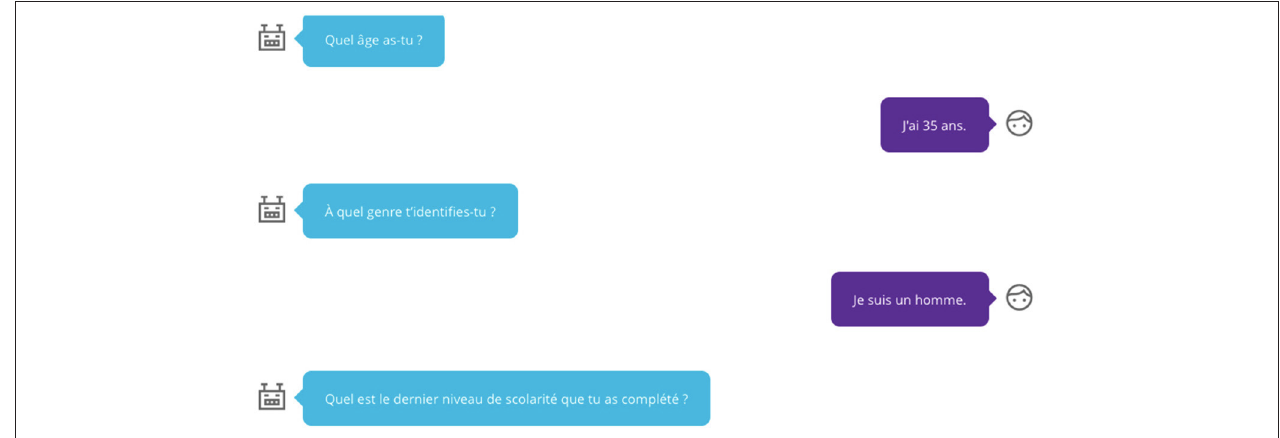
FIGURE 1 | Example of some sociodemographics